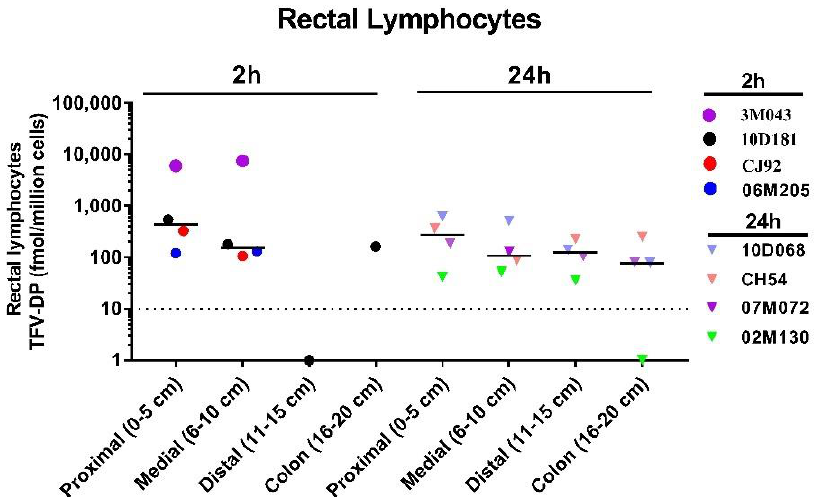
Figure 6. Intracellular TFV-DP levels in rectal lymphocytes were collected 2 and 24 h post-dosing with PEG suppositories containing TAF/EVG (8/8 mg). Dotted line denotes the lower limit of quantitation (LLOQ). Each color/symbol represents an individual